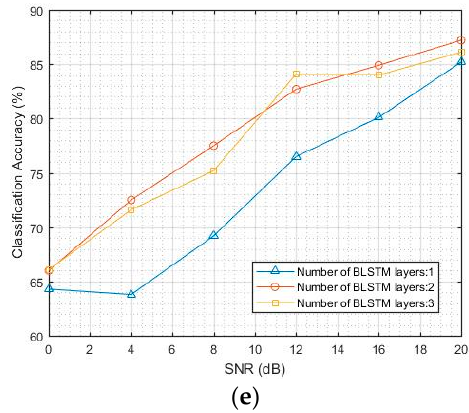
Figure 5. Classification accuracy of convolutional neural network (CNN) and LSTM models. ( a ) Classification accuracy of CNN when the number of convolution kernels is from 8 to 64; ( b ) Classification accuracy of CNN when the size of convolution kernels is from 10 to 40; ( c ) Classification accuracy of CNN when the number of convolution layers is from 1 to 4; ( d ) Classification accuracy of Bi-LSTM when the number of memory cells is from 16 to 128; ( e ) Classification accuracy of Bi-LSTM when the number of hidden layers is from 1 to 3.